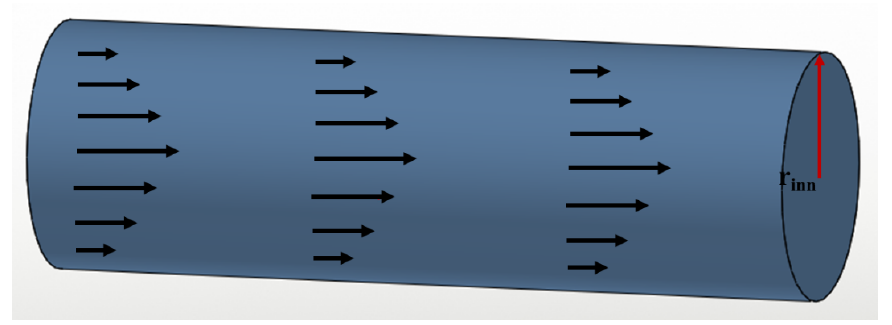
Figure 25. The flow of a Poiseuille tube inside a needle.